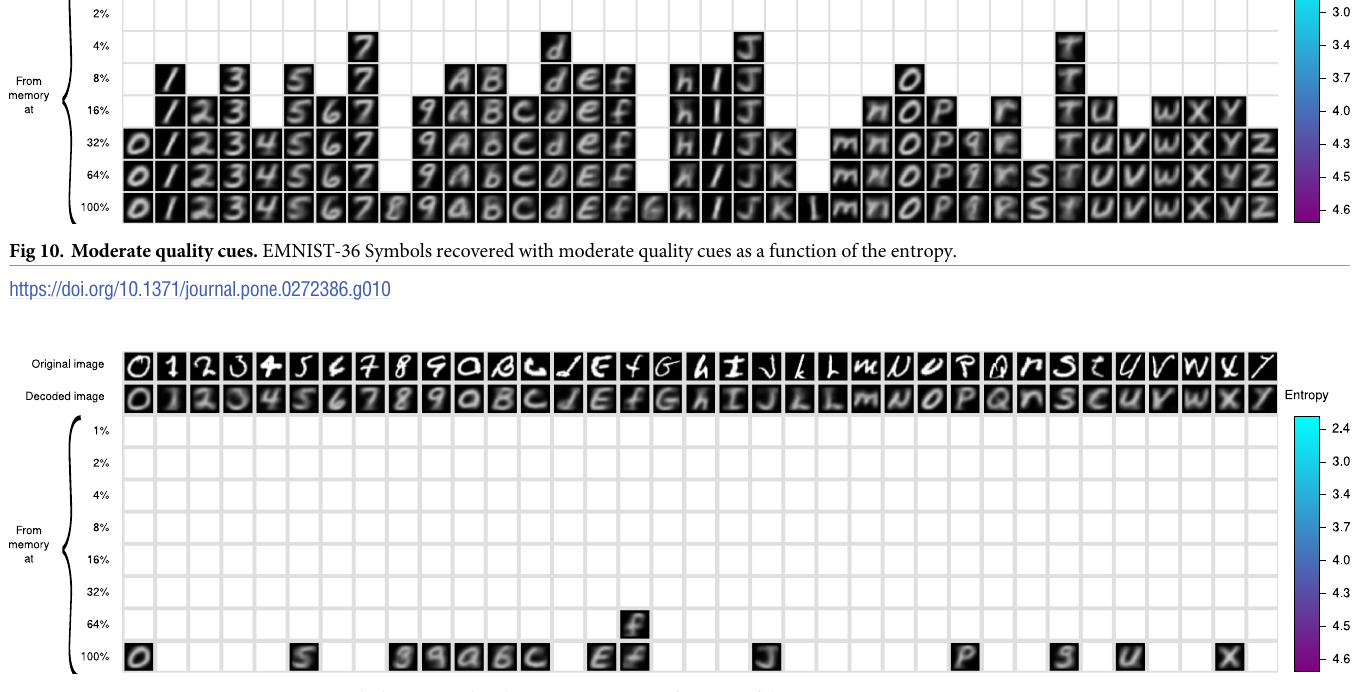
PLOS ONE | https://doi.org/10.1371/journal.pone.0272386 August 4,